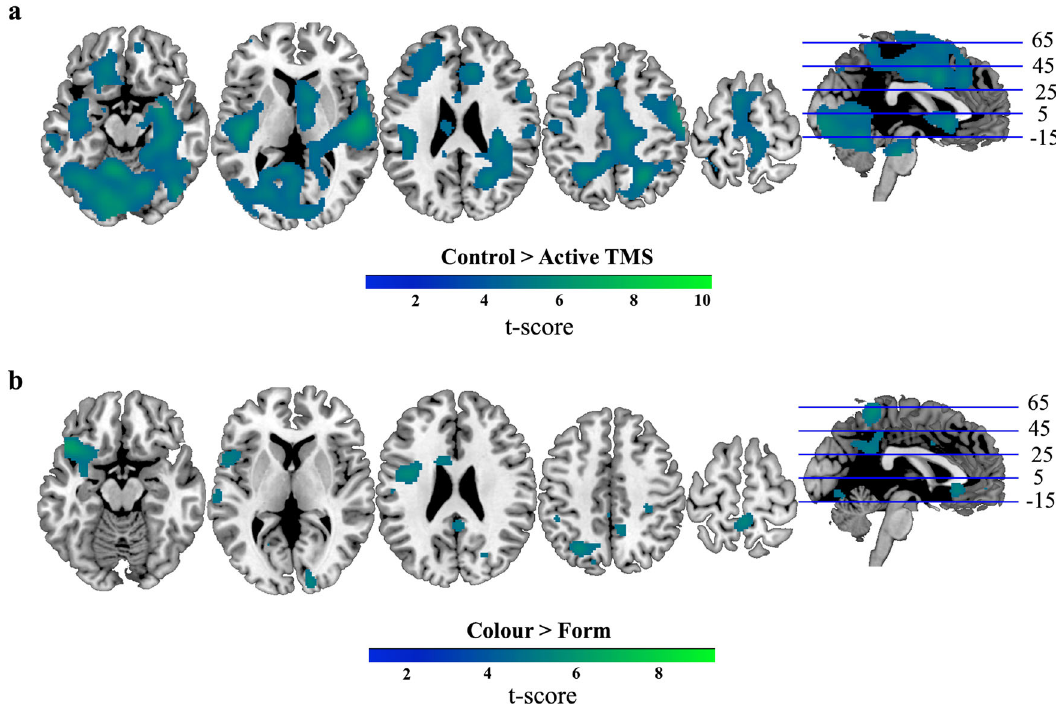
Fig. 8 Information coding assessed with a roaming searchlight as revealed by a three-way repeated-measures ANOVA. Whole-brain maps indicate where patterns of activation in the local neighbourhood (10-mm sphere) discriminated information more strongly under Control > Active TMS ( a ), and for decoding of Colour > Form ( b ), revealed as main effects in the three-way repeated-measures ANOVA. The results were thresholded at P < 0.0001 (FWE correction of P < 0.05 at cluster level). N = 20 participants. Axial slices are depicted in neurological convention (i.e., the left hemisphere is on the left-hand side of the